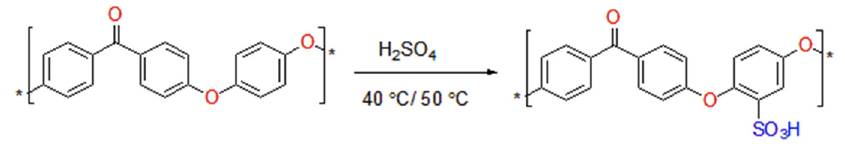
Figure 1. Sulfonation of